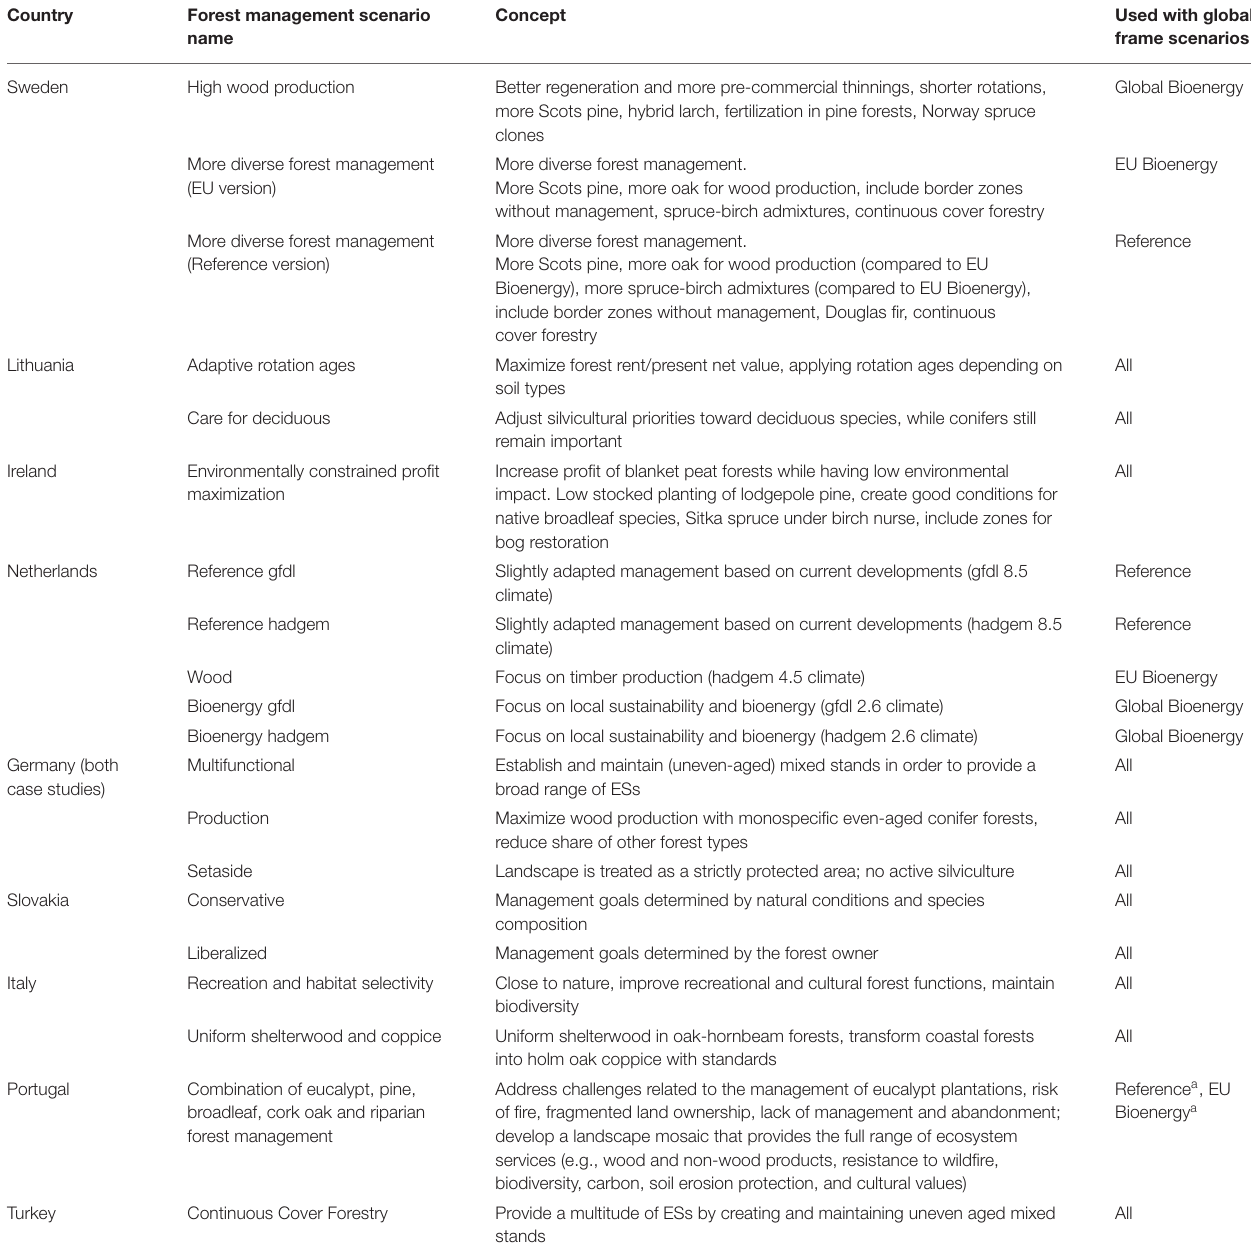
TABLE 2 | Overview of the forest management scenarios used in this study [after Biber et al. (2019), modified].